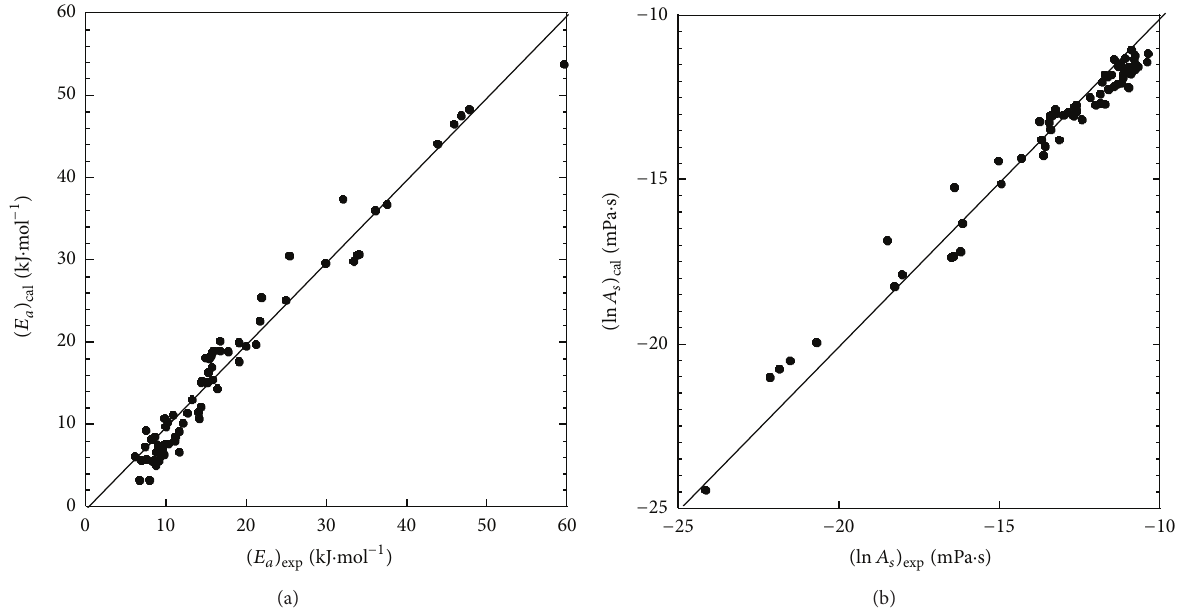
Figure4:(a)Comparisonbetweentheexperimentalactivationenergyvalues (𝐸 𝑎 ) exp andtheestimatedones (𝐸 𝑎 ) between the experimental entropic factor values ( ln 𝐴 𝑠 ) exp and the estimated ones ( ln 𝐴 𝑠 )